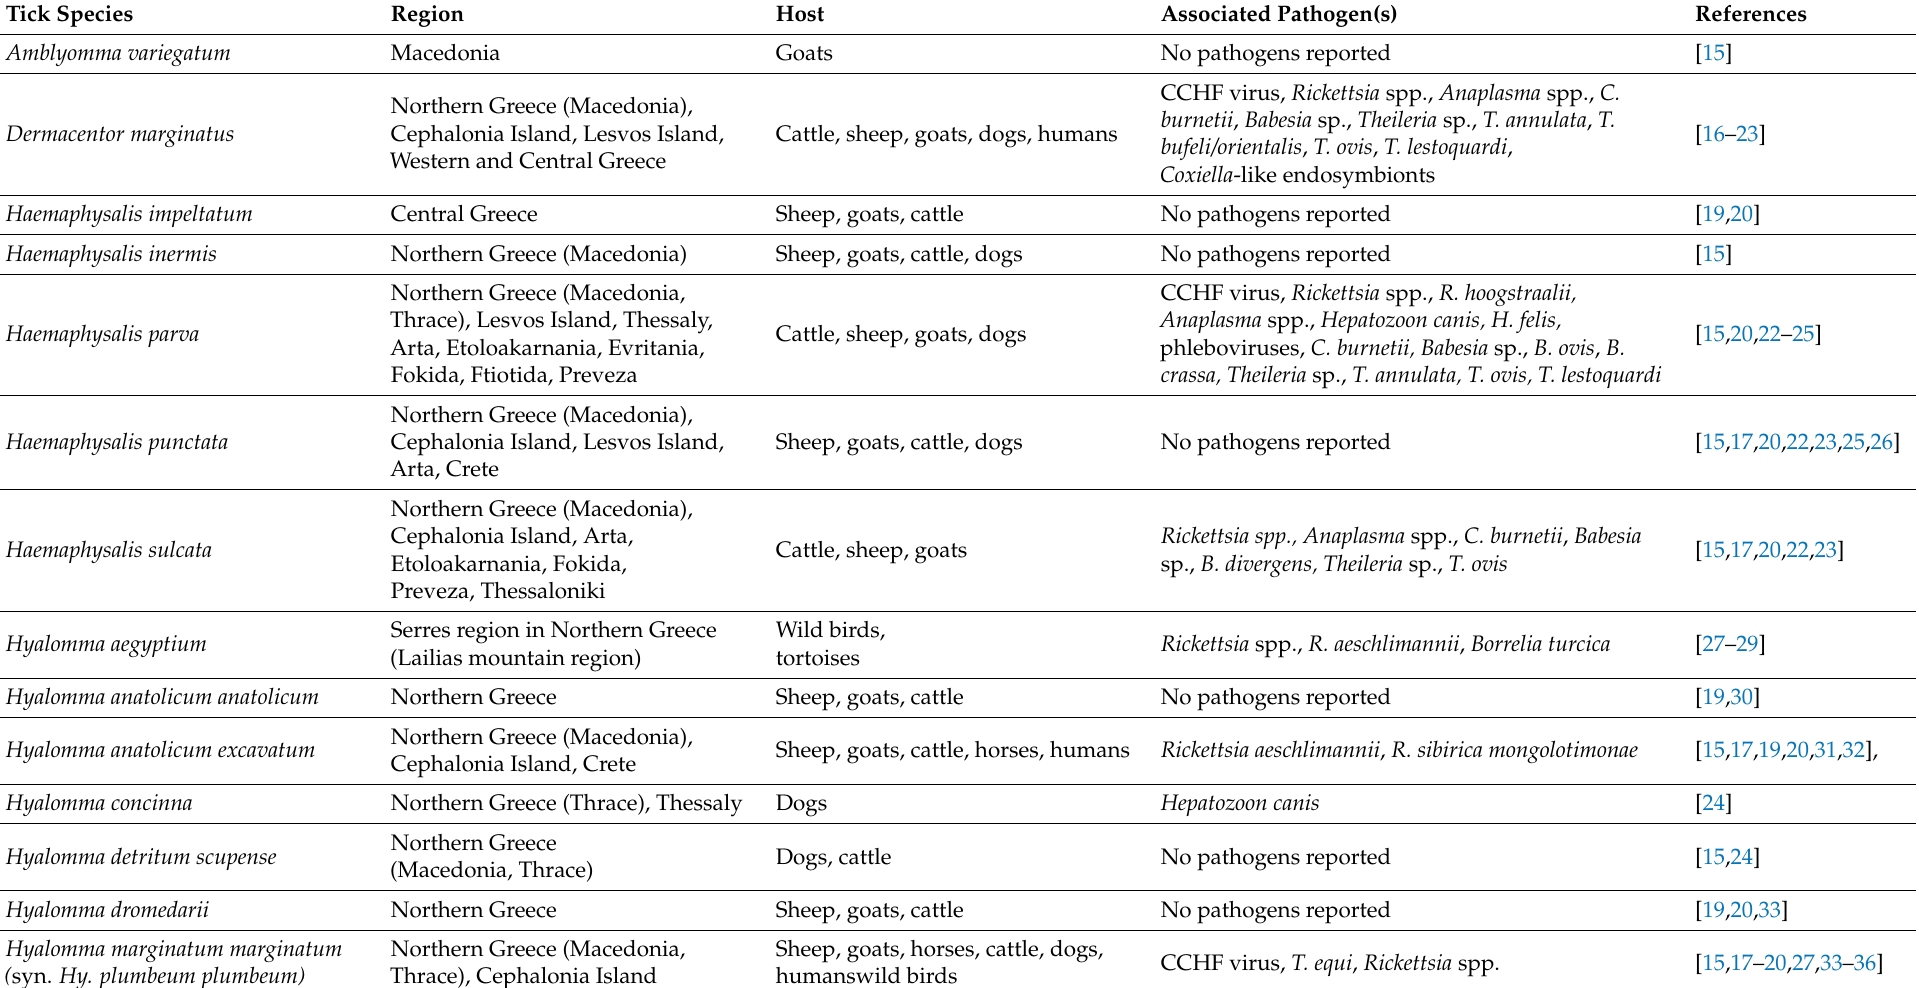
Table 1. Hard tick species ( Ixodidae) found in Greece and their associated pathogens, hosts, and regions of emergence. Tick Species